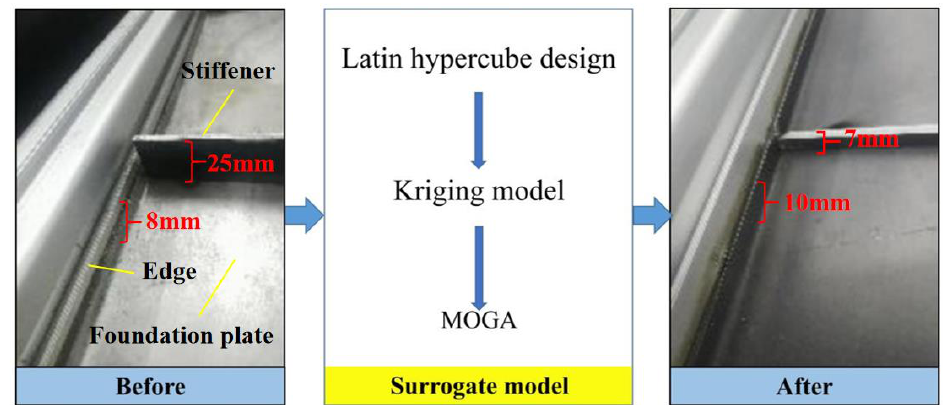
Figure 18. Comparison of panels before and after optimization.